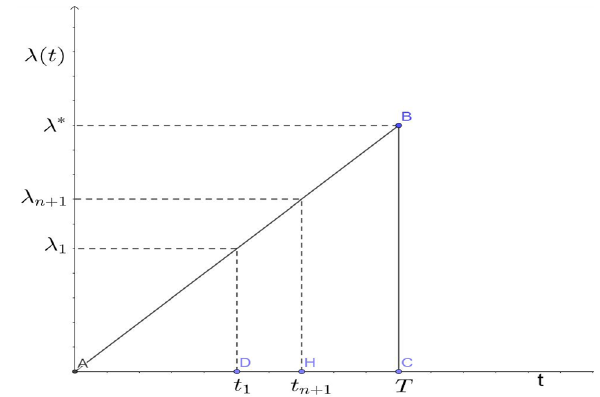
Fig. 3 Linearly increased-ramp dynamic load. Here 𝜆 stands for generalized dynamic load (i.e., Force, load factor, applied